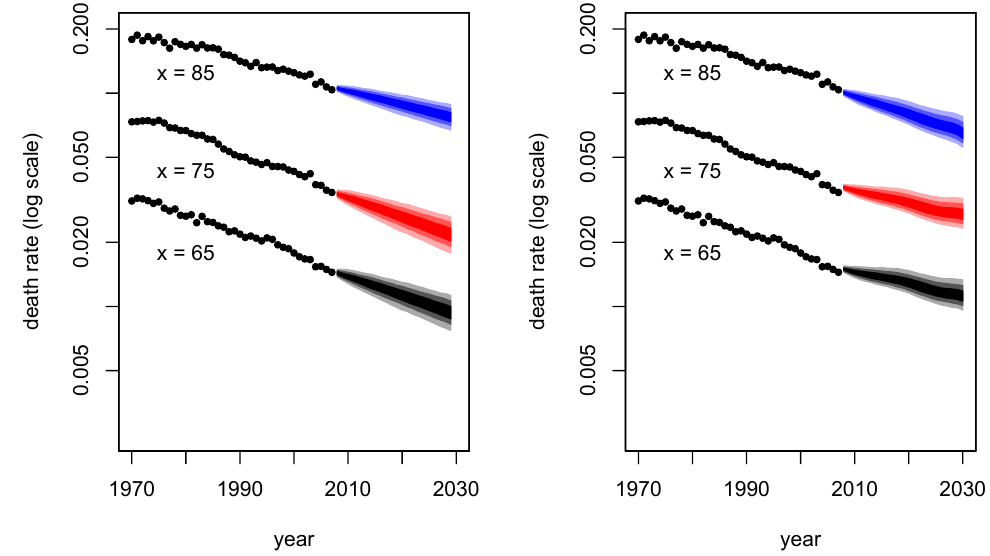
Figure 8. Fan charts for death rates µ x , t at ages x = 65, x = 75, x = 85 from the Lee–Carter model on the left and from the regularized elastic net model on the right to the French population. The dots show historical death rates from 1970–2007 and shades in the fan represent prediction intervals at the 50%, 80% and 95%